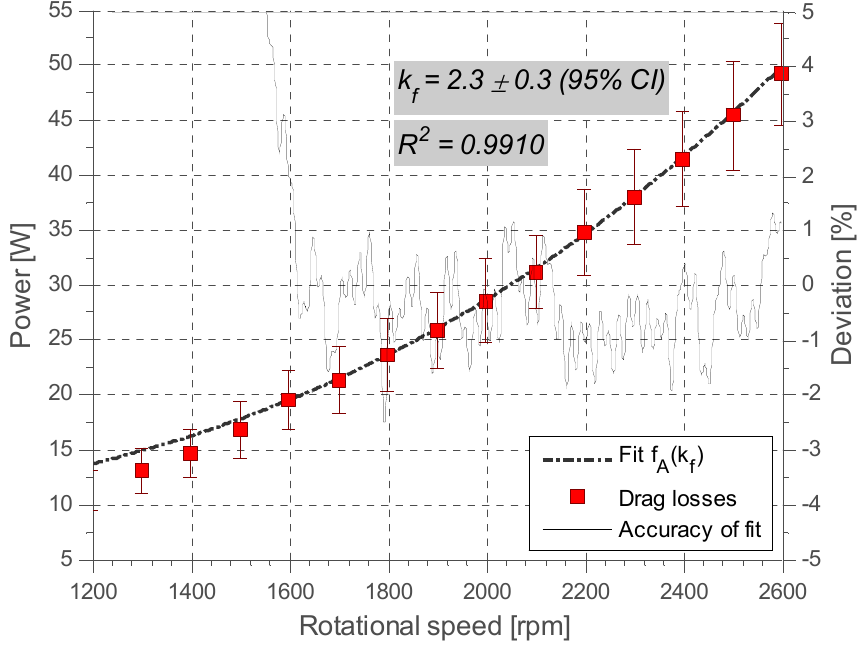
Figure 8. Measured power loss due to air friction at 1 bar. A roughness factor of 2.3 ±